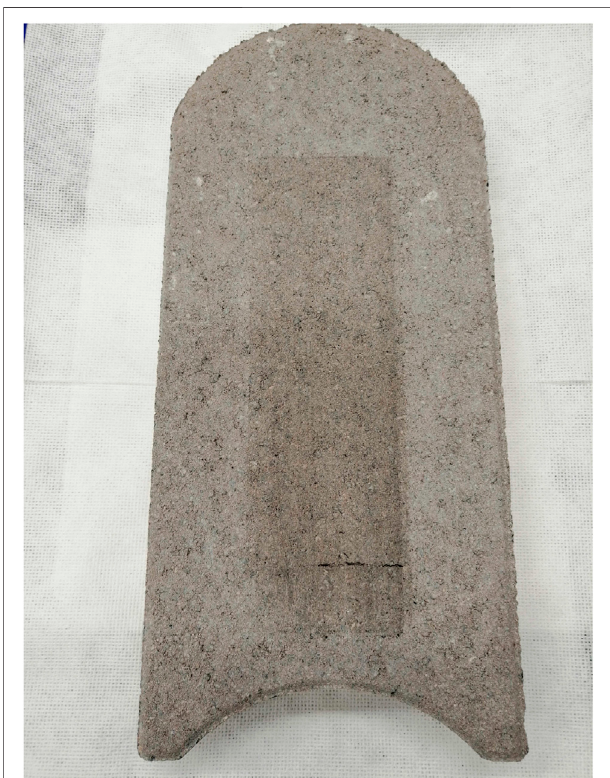
FIGURE 14 | Picture of concrete block b after run-in of compound